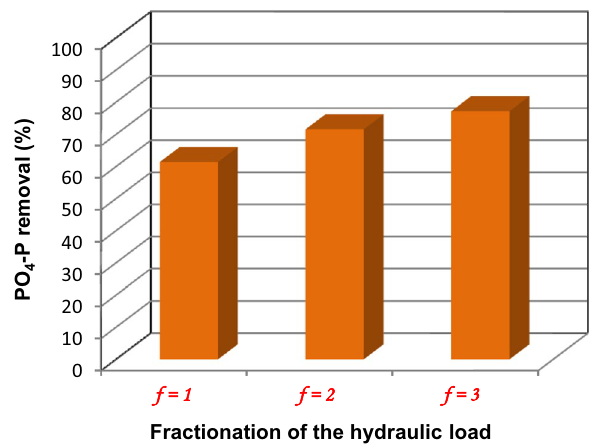
Fig. 3 Influence of fractionation on PO